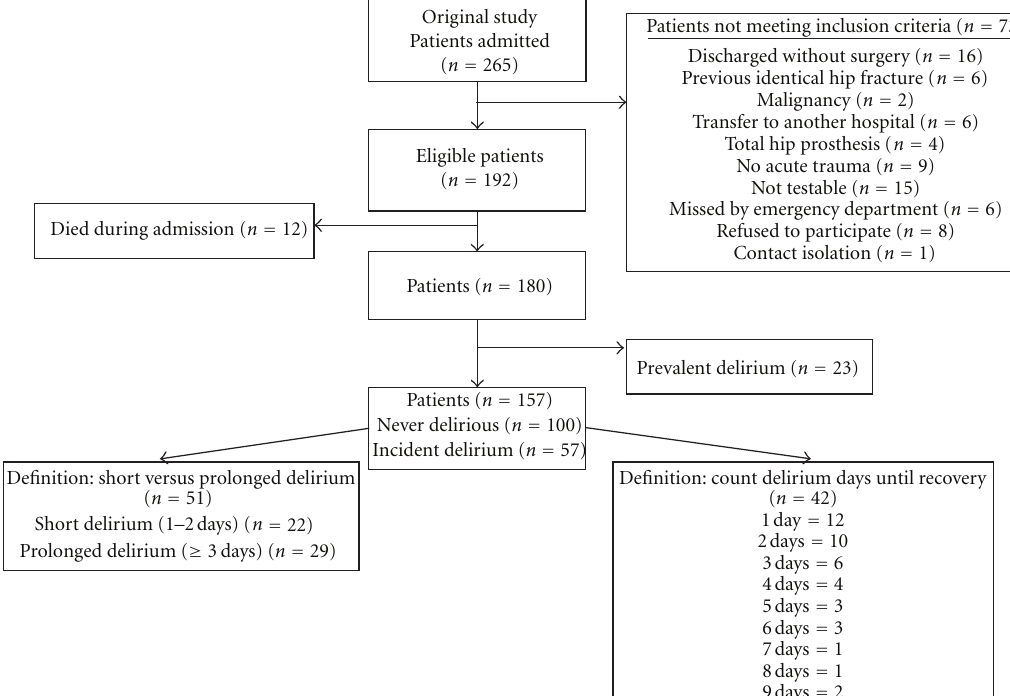
Figure 1: Flow diagram of the